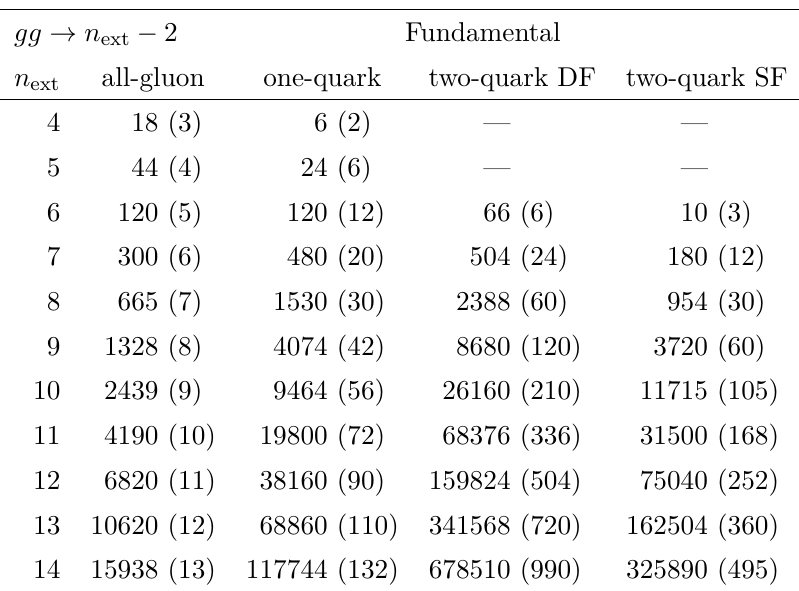
Table 6 . Number of non-zero elements in the colour matrix at NLC and at LC (in parenthesis) including the reduction due to the phase-space symmetrisation, for gg initial states for all-gluon, one- quark-pair and two-quark-pair (same-flavour (SF) and distinct-flavour (DF)) processes for various numbers of final-state particles ( n 2 ) in the fundamental representation. ext −